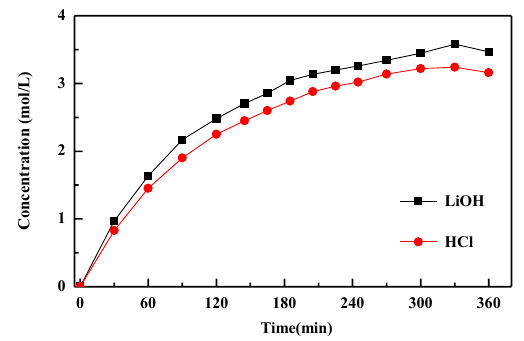
Fig. 13 The maximum achievable concentration of HCl and LiOH in BMED